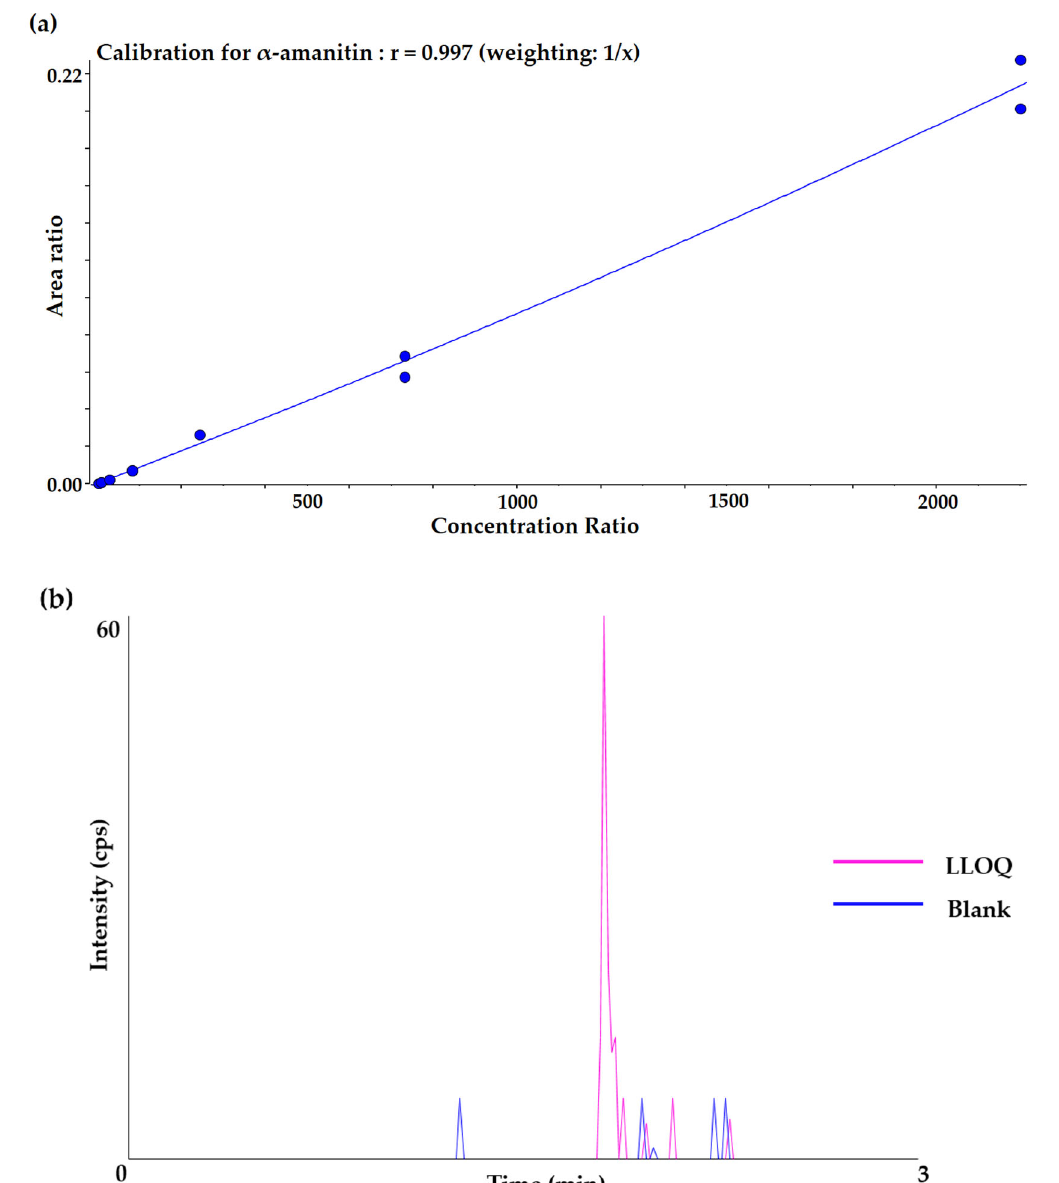
Figure 2. ( a ) Calibration curve for quantification and ( b ) chromatogram of LLOQ and blank samples of α -amanitin in rat plasma. Table 1. QC results and statistics from the intra/inter-run assays for α -amanitin in rat